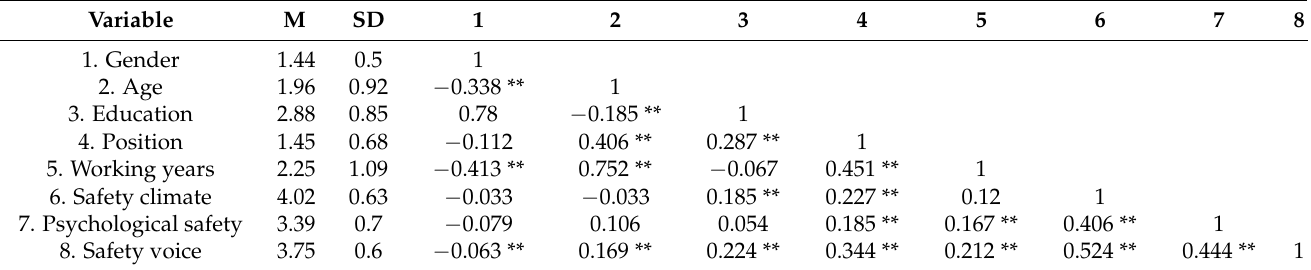
Table 3. Results of descriptive analysis.